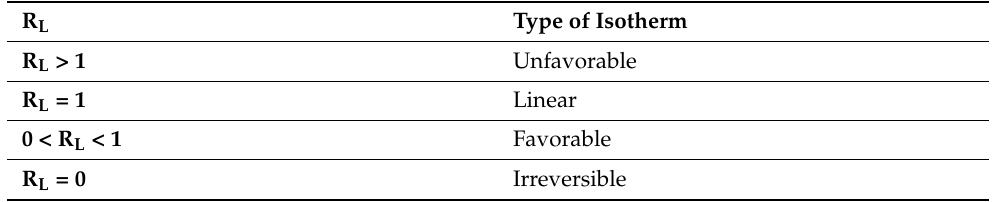
Table 3. Relationship between RL and the type of isotherm [92].